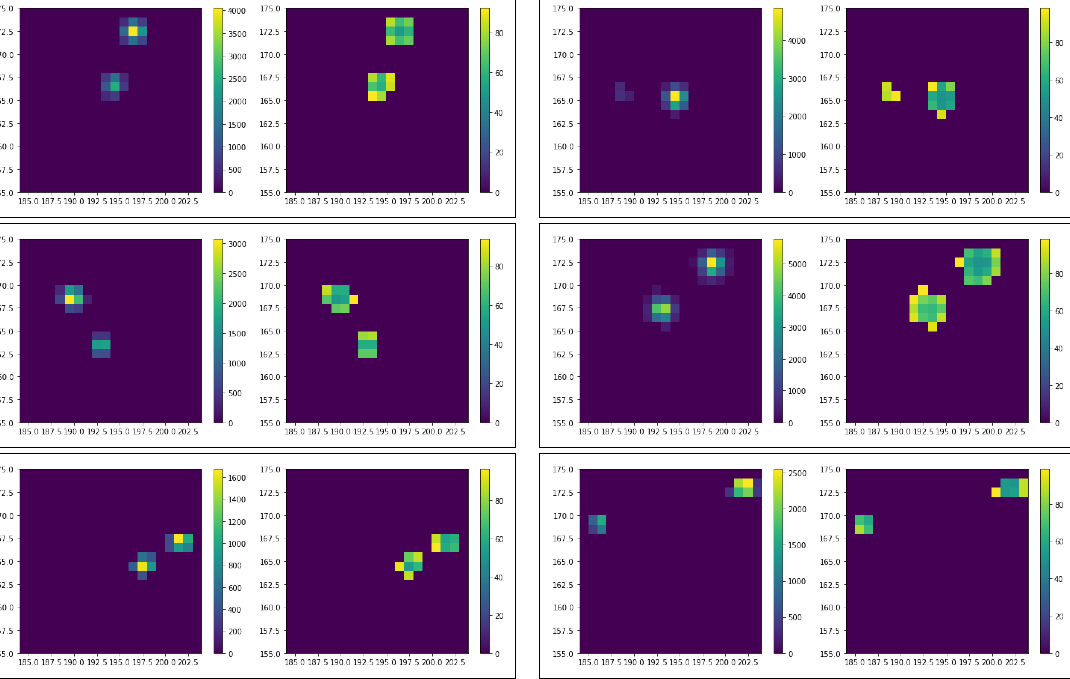
Figure 8. Six examples of two clusters in a single fiber (fiber 2) separated by less than 100 ns. The hits are shown as boxed pairs of heatmaps in time-over-threshold (ToT) representation (left graph in the boxed pair of graphs) and time of arrival (ToA) representation (right